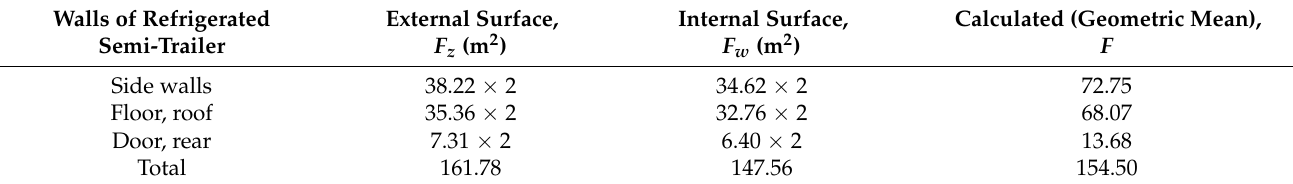
Table 2. Input data for calculations of semi-trailer heat balance.